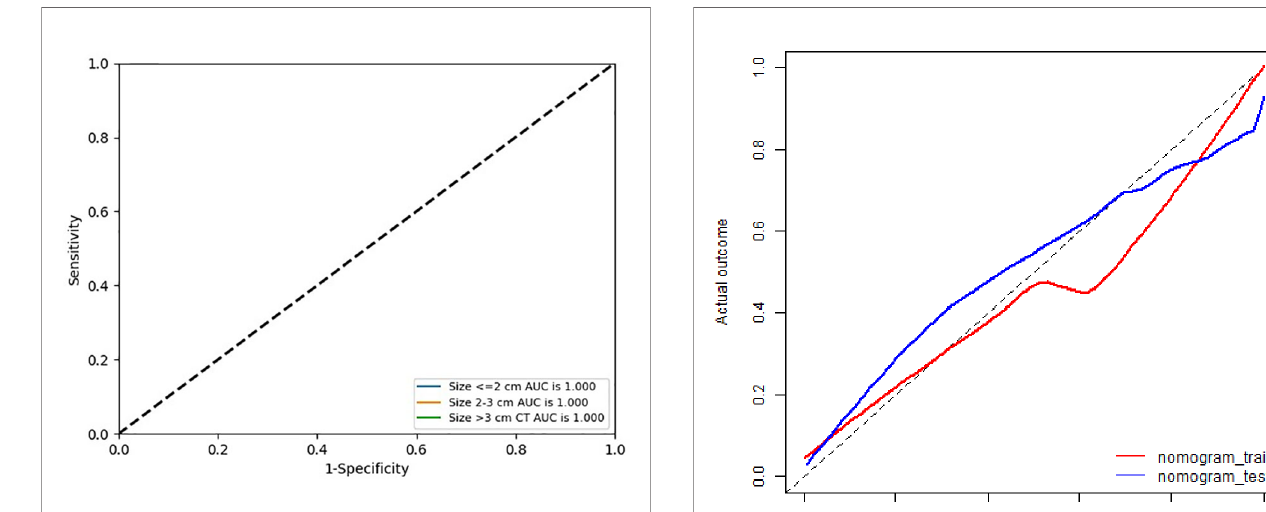
FIGURE 5 | ROC curves of radiomics nomogram in the strati fi cation veri fi cation according to the size in the validation cohort.